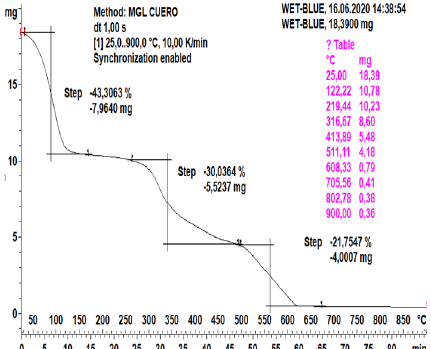
Figure 3. Thermogravimetric analysis of leather tanned with chromium.